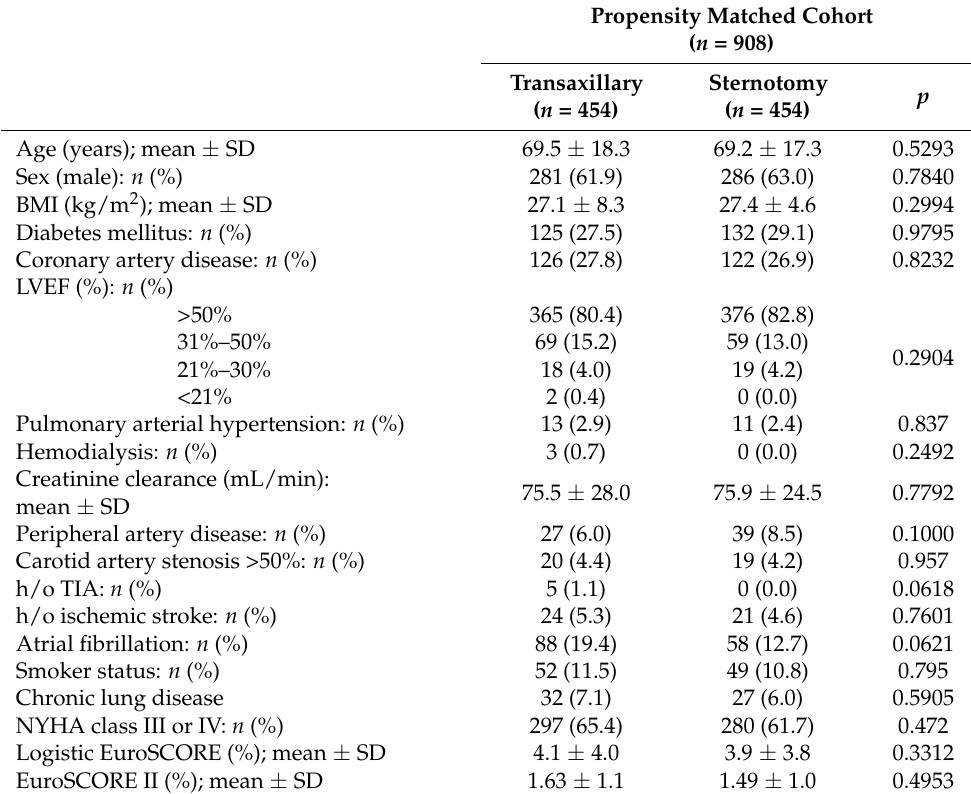
Table 2. Clinical baseline characteristics.